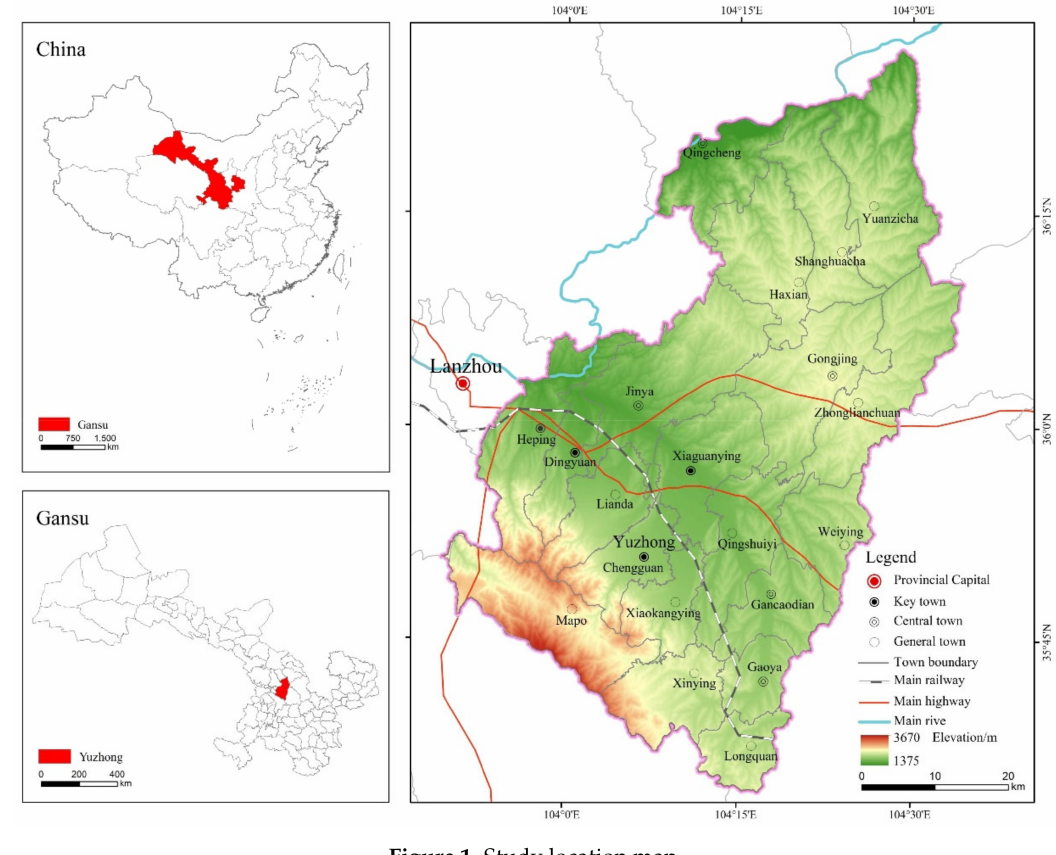
Figure 1. Study location map. Table 1. Township